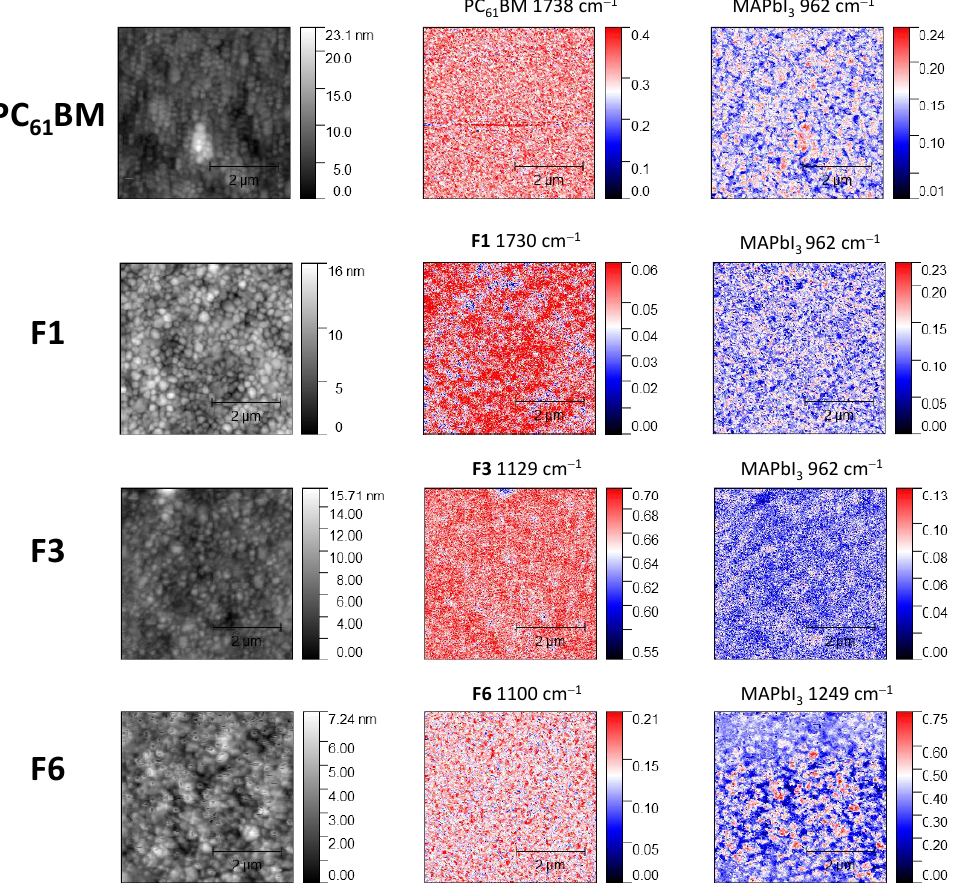
Figure 2. Some typical cases of perovskite/ETL bilayer stack morphology: topography ( left column ) and IR s-SNOM images recorded at the characteristic frequencies of the ETL material ( middle column ) and perovskite absorber ( right column ). The used fullerene derivatives are listed on the left side.